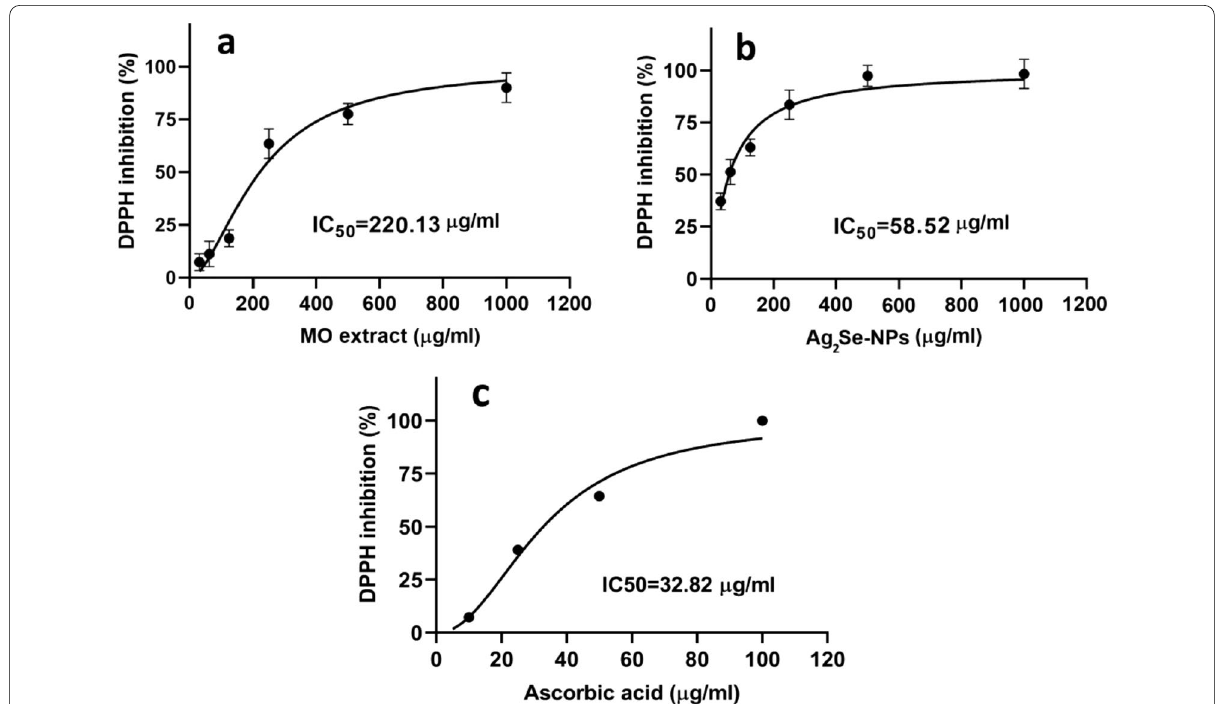
Fig. 7 Antioxidant activities of a Ag 2 Se-NCs, b MO extract and c ascorbic acid (control)